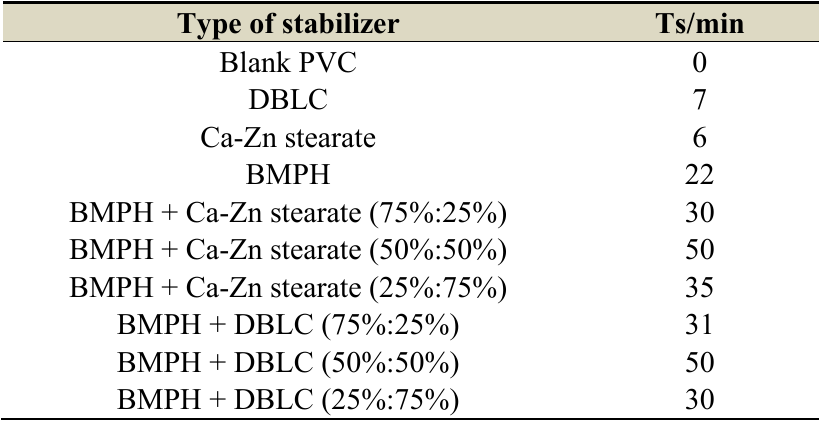
Table 1. Thermal stability values of rigid PVC thermally degraded at 180 °C in air, in the presence of BMPH, reference stabilizers and mixed